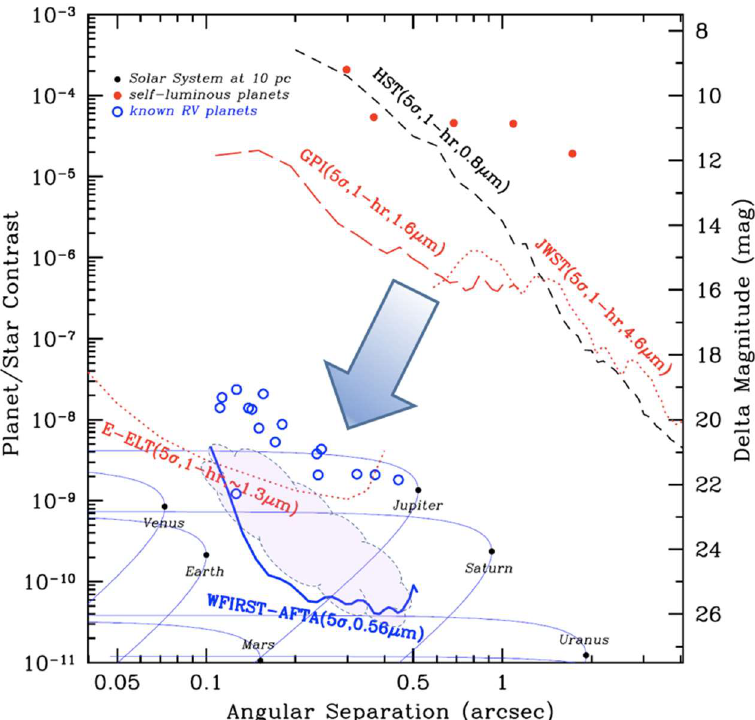
Figure 10. Exoplanet detection limit of the hybrid-Lyot coronagraph on WFIRST-AFTA, compared to other high-contrast systems. GPI stands for the Gemini Planet Imager and ELT for the extremely large telescope. Both are ground-based observatories. The only space telescope flown with capabilities for coronagraphy is HST. The blue open dots are planets found by the detection of stellar radial velocity variations. For comparison, LUVOIR/ECLIPS expected IWA is 14.4 mas at 200 nm (UV) and 37 mas at 525 nm (optical range), (figure from [29]).